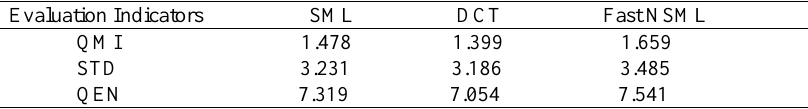
Table 1. Image objective evaluation results.